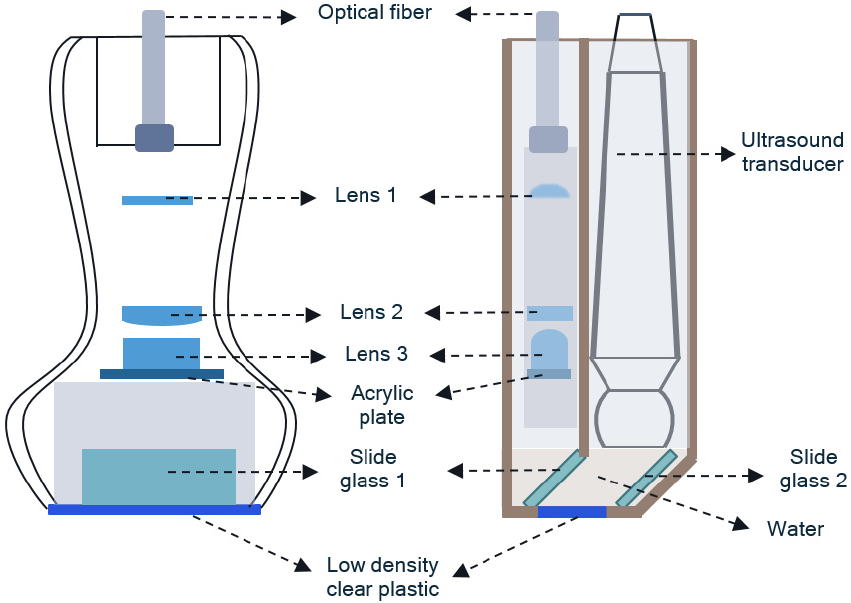
Fig. 7. Schemes of a handheld probe with the illuminated light beam axis coincides with the axis of the ultrasound through a beam combiner.